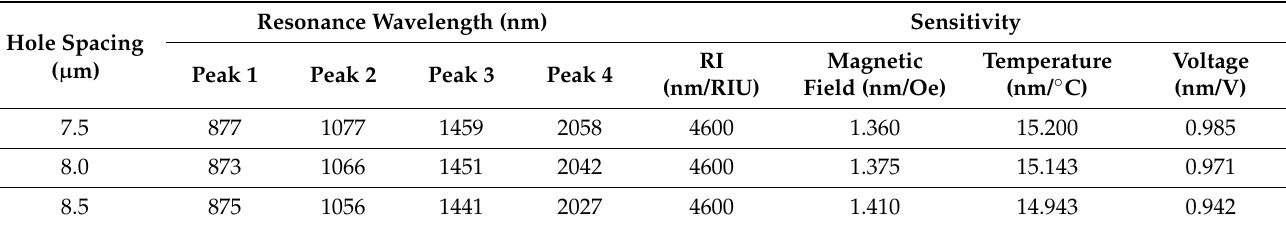
Figure 8. ( a ) The loss spectrum of the core guide mode with different hole spacing Λ . The variation relationship between the resonance wavelength and the external parameters ( b ) magnetic field, ( c ) temperature, and ( d ) voltage. Table 2. Effect of hole spacing variation on